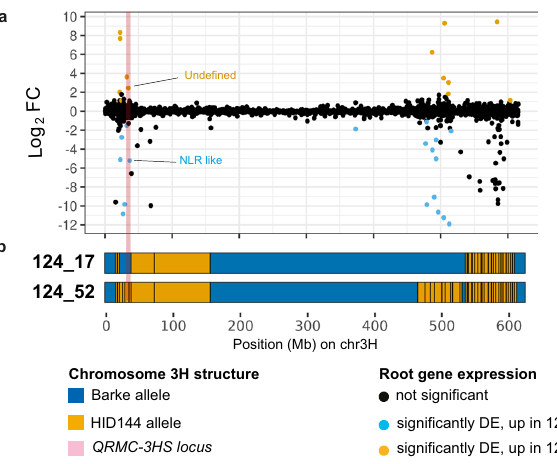
Fig. 5 Differentially expressed genes mapping at locus QRMC-3HS . a Dots depict individual genes and their expression pattern in the pair-wise comparison 124_17 vs. 124_52 (log 2 Fold-Change), colour-coded according to their signi fi cance as illustrated at the bottom of the fi gure (EdgeR, individual P -values < 0.01, FDR corrected). b Projection of the individual genes on the structures of chromosome 3H for the lines 124_17 (elite-like) and 124_52 (wild-like), respectively, colour-coded according to allelic composition as indicated in the key at the bottom of the fi gure. The physical location of locus QRMC-3HS is highlighted in pale pink. Source data are provided as a Source data fi